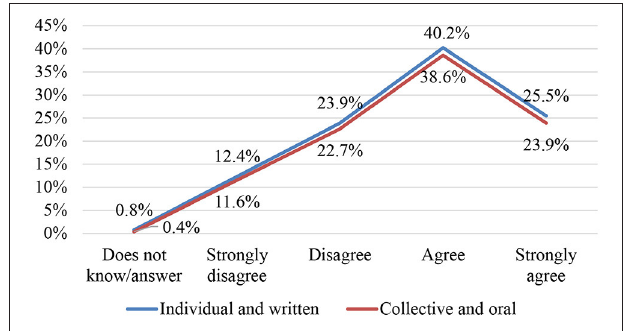
FIGURE 5 | Individual and written text commentary—collective and